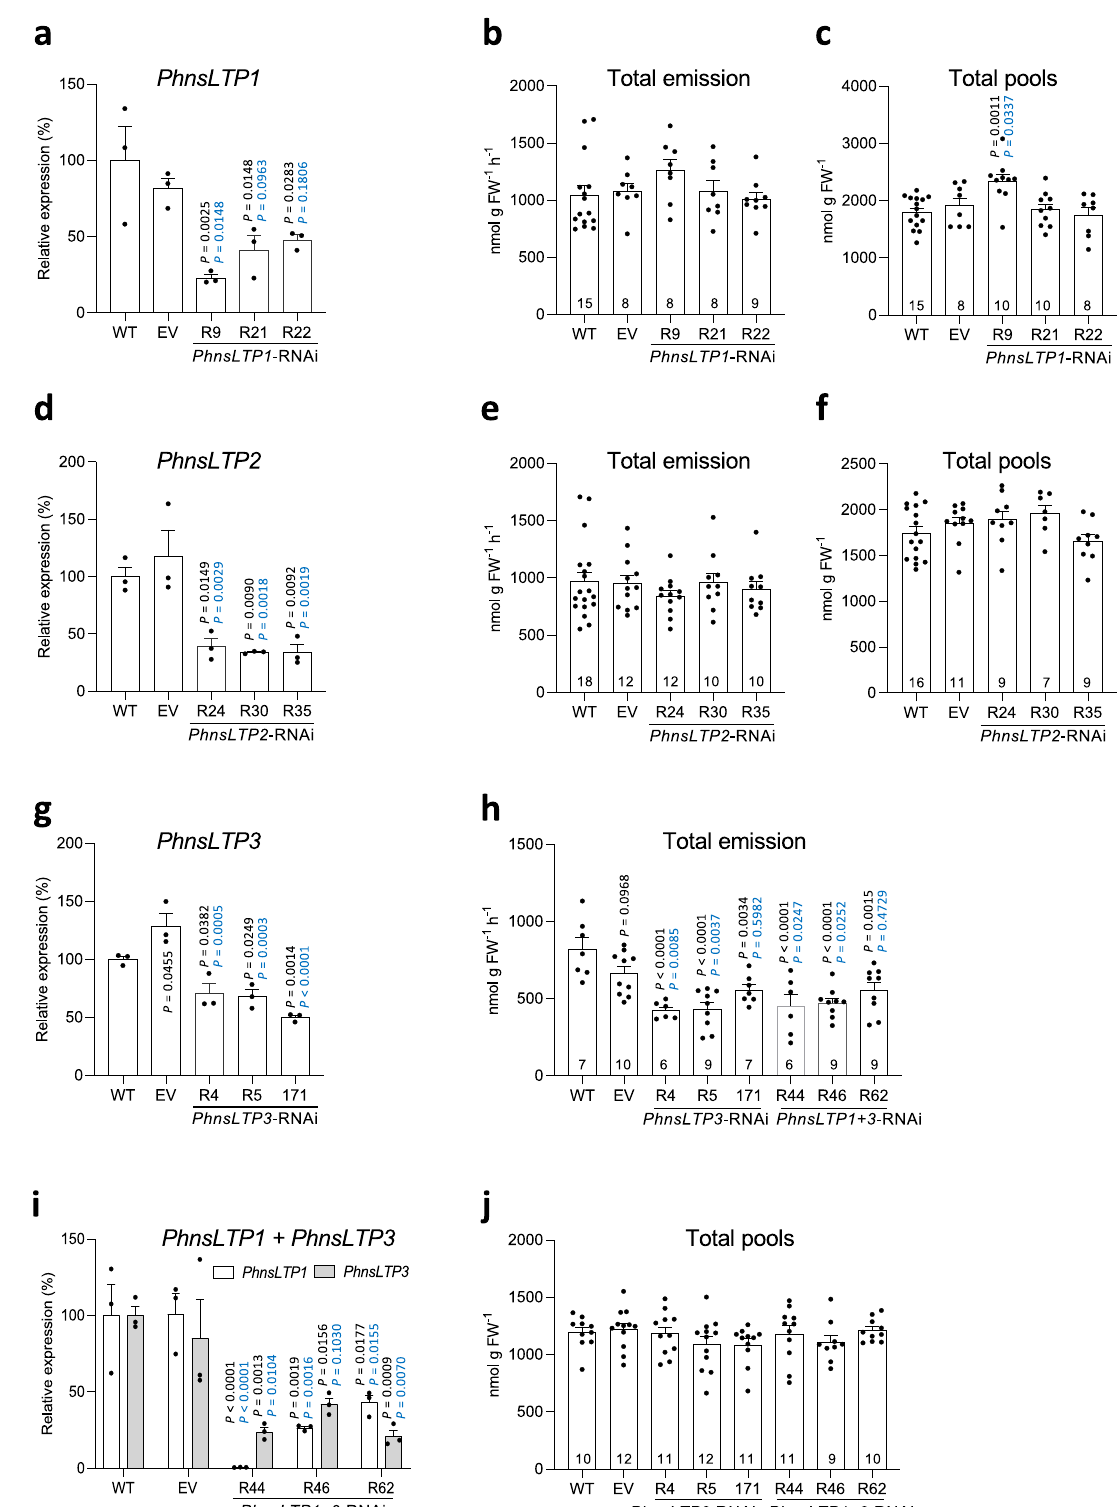
Fig. 3 | Effect of PhnsLTP1 , PhnsLTP2 , PhnsLTP3 and PhnsLTP1 + PhnsLTP3 downregulation on the emission of VOCs and their total pools in petunia fl owers. Transcript levels of PhnsLTP1 ( a ), PhnsLTP2 ( d ), PhnsLTP3 ( g ) and PhnsLTP1 + PhnsLTP3 ( i ) determined by qRT – PCR with gene-speci fi c primers in 2-day-old wild-type petunia fl owers (WT), empty-vector control (EV) and the cor- responding three independent transgenic lines with the greatest reduction in gene expression, harvested at 15:00h. Data are shown as a percentage of a corre- sponding gene expression in WT set as 100% and are means±S.E. ( n =3 biological